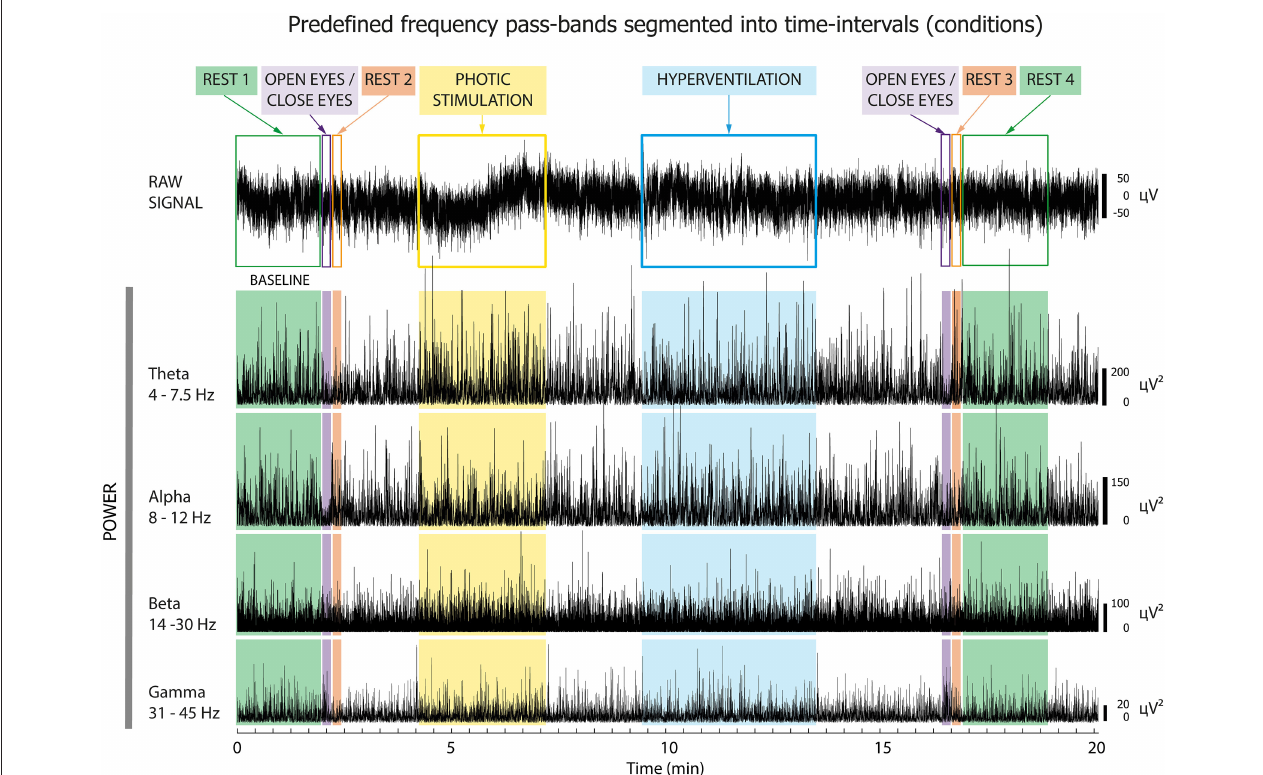
FIGURE 1 | Pre-processing of EEG signal. The EEG was segmented into eight time intervals, and then filtered into four frequency bands: theta, alpha, beta, and gamma. Subsequent analyses focused on the oscillatory power changes within these intervals, which were analyzed separately for each frequency band.